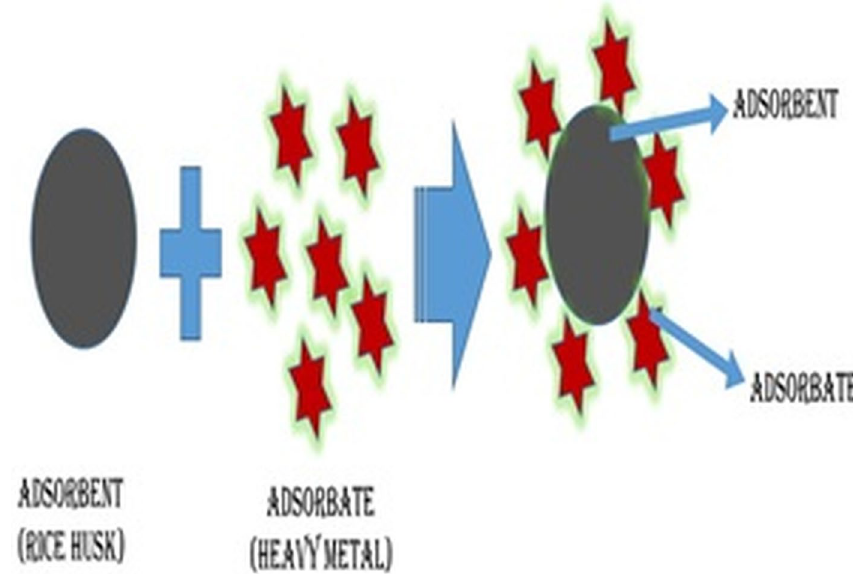
Fig. 6 Schematic diagram for adsorption of the heavy metal